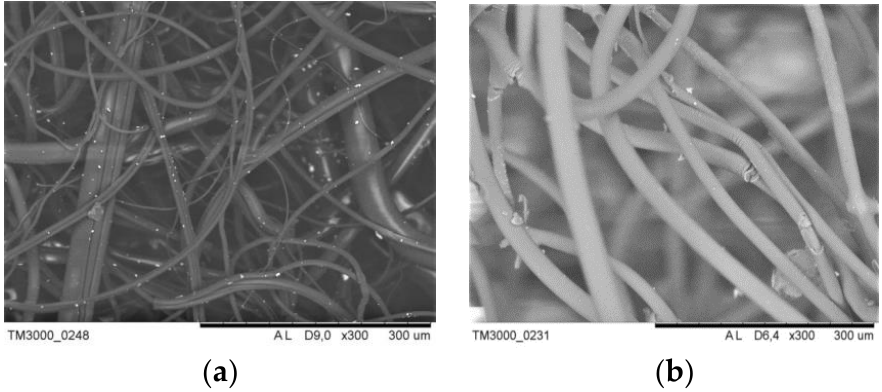
Figure 1. SEM-image of the polypropylene fiber with fixed Fe 0 particles using SHF-irradiation ( a ) and II ( b ) methods.